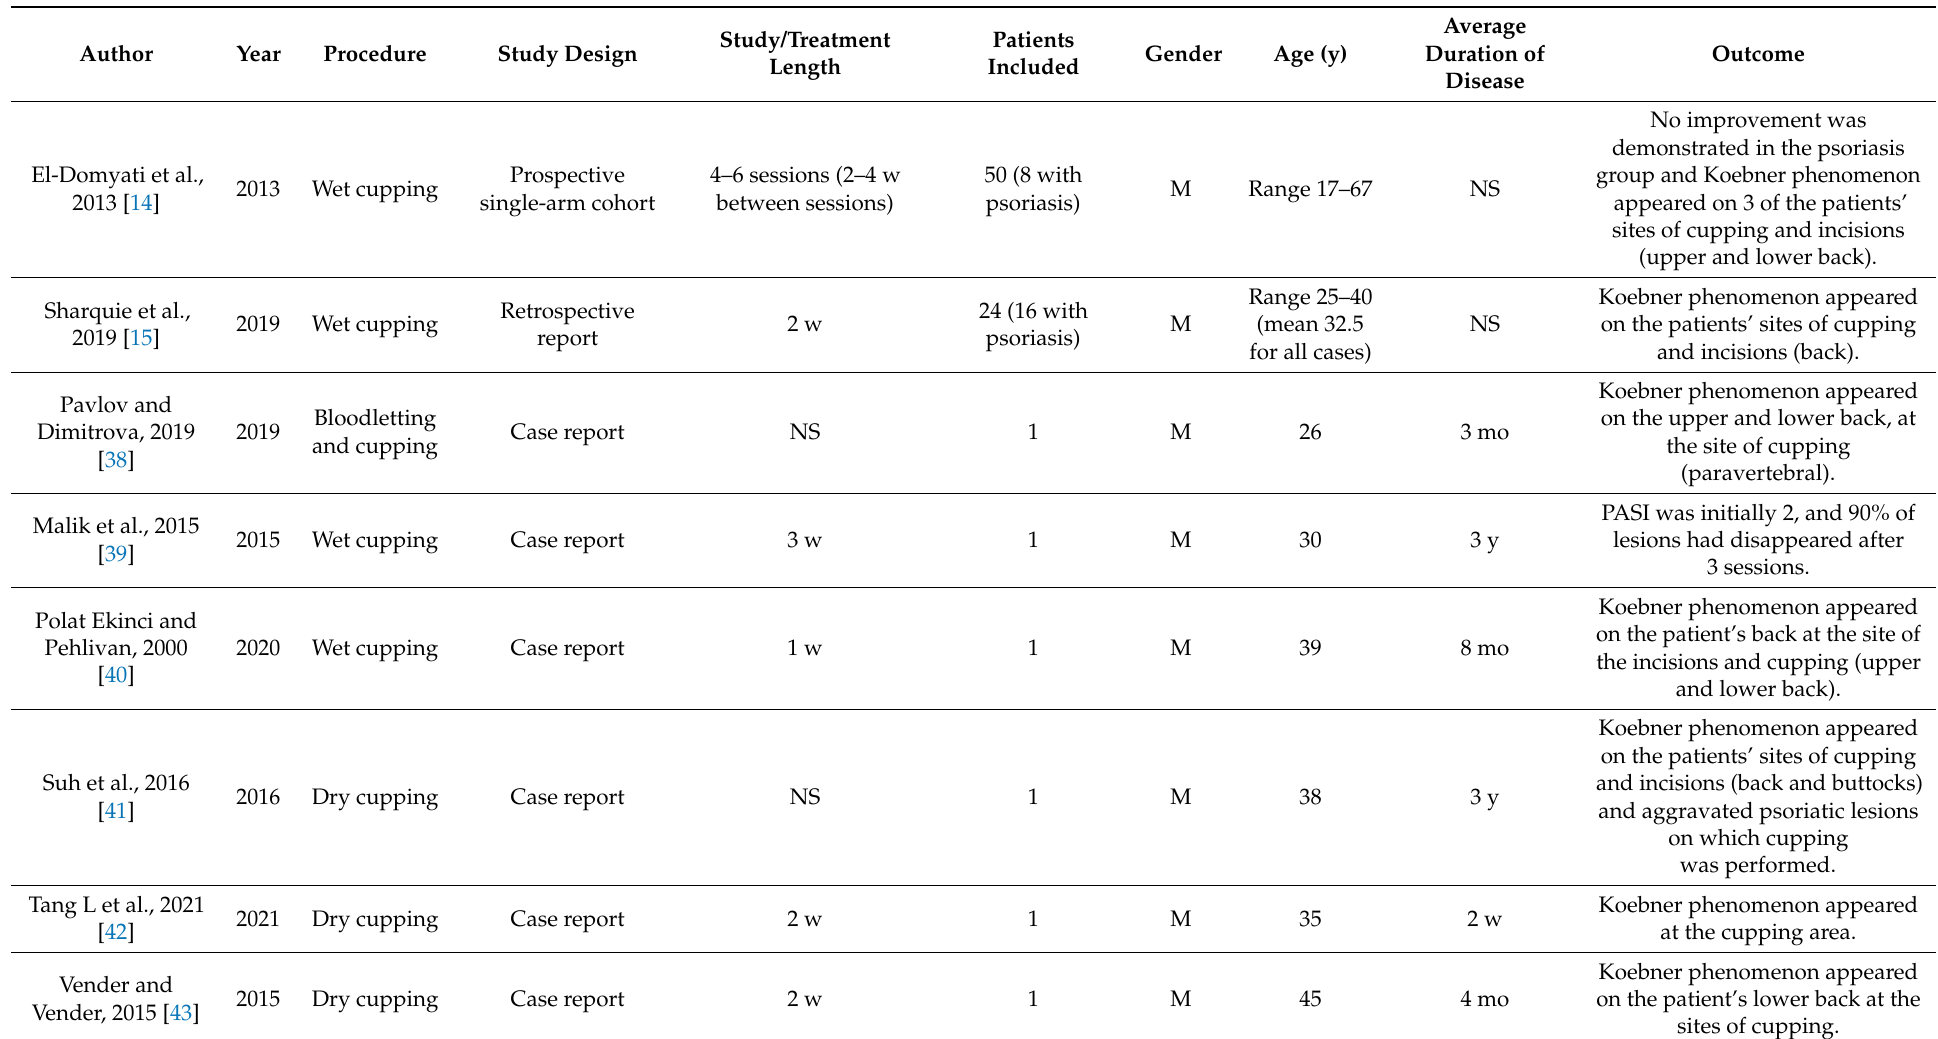
Table 2. Clinical studies on patients undergoing dry and wet cupping therapy for psoriasis (arranged in order of